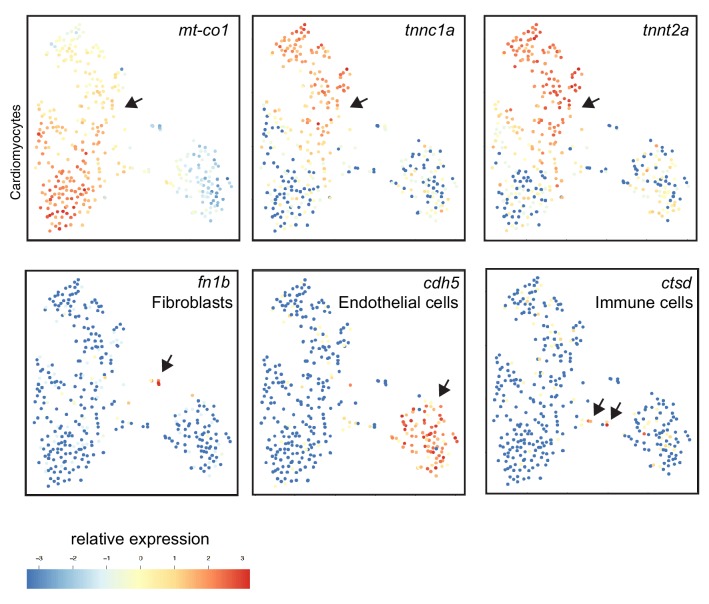
Single-cell mRNA sequencing identifies different cell-populations in the injured zebrafish heart.tSNE maps visualizing log2-transformed read-counts of genes with high expression in cardiomyocytes (mt-co1, tnnc1a, tnnt2a), in fibroblasts (fn1b), in endothelial cells (cdh5) and immune cells (ctsd). Arrow indicates positive cell populations.